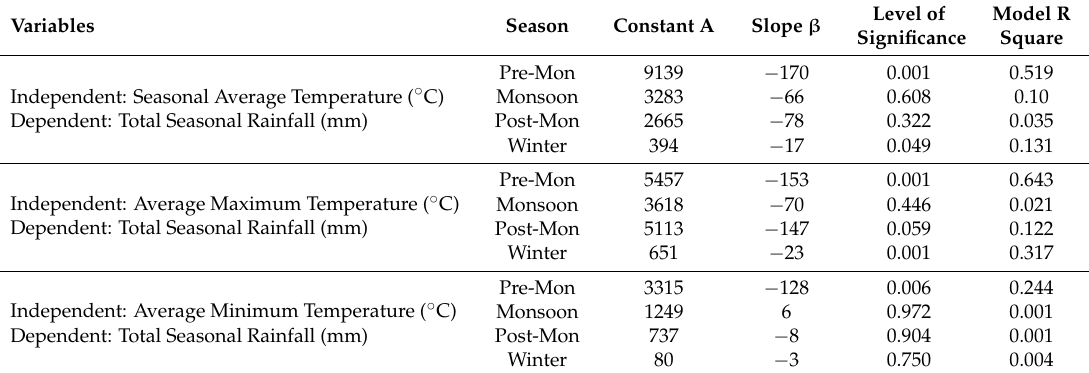
Table 1. Interrelation between temperature and rainfall in different seasons in